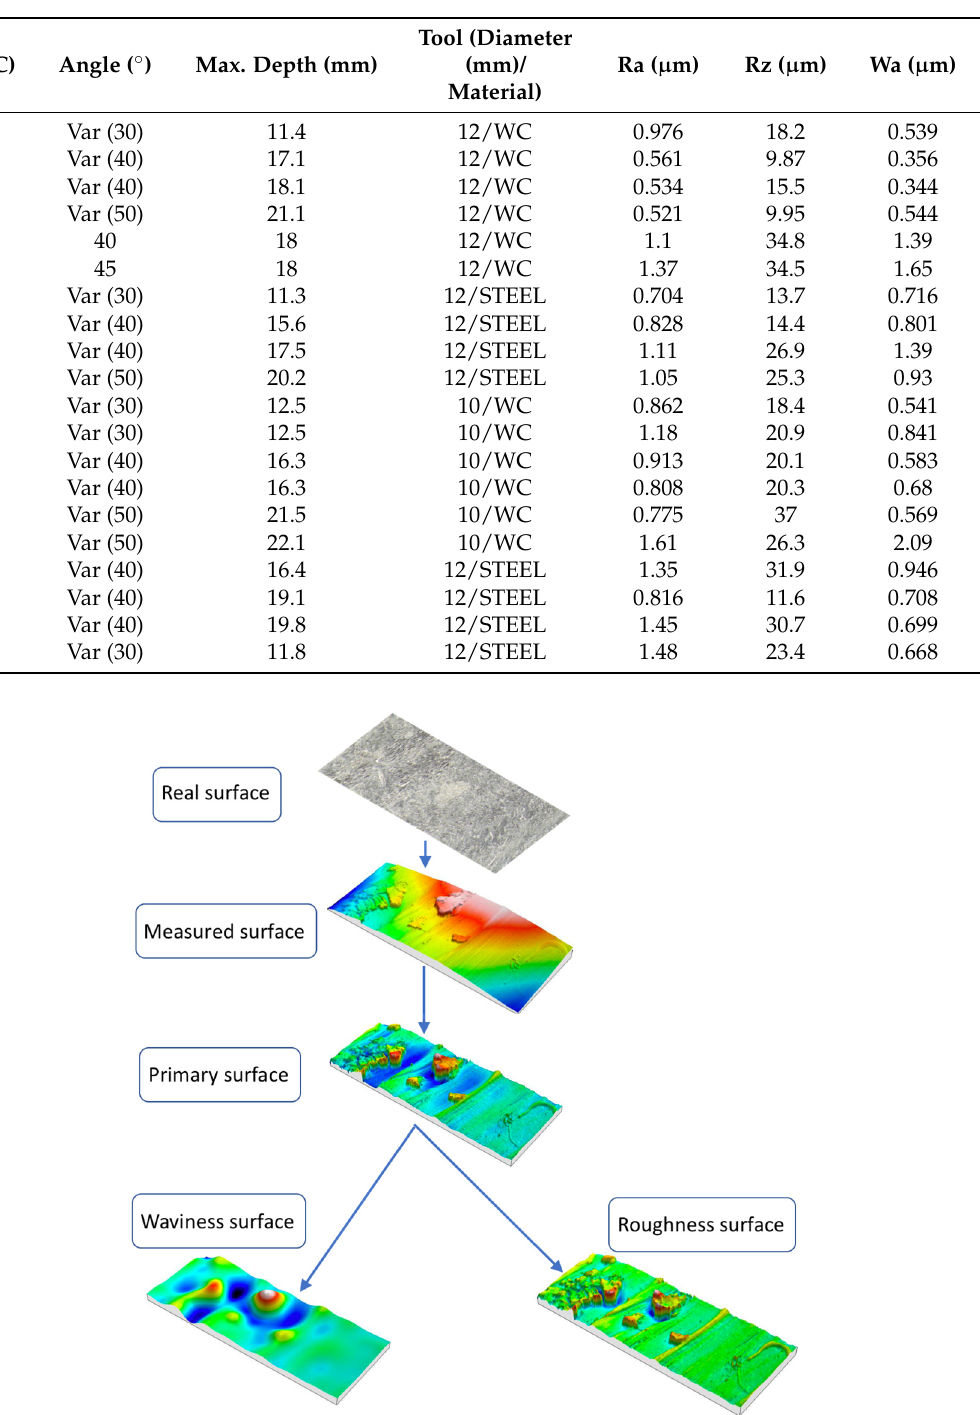
its shape (the curvature in this case) is removed. Finally, by using a gaussian filter, the irregularities of the primary profile can be split up in the roughness and waviness profiles. Table 1. Single point incremental forming parameters and surface finish values. The value of wall angle in brackets corresponds to the maximum angle formed. (Initial sheet thickness = 0.8 mm, pitch = 0.5 mm/rev, feed rate = 600 mm/min).